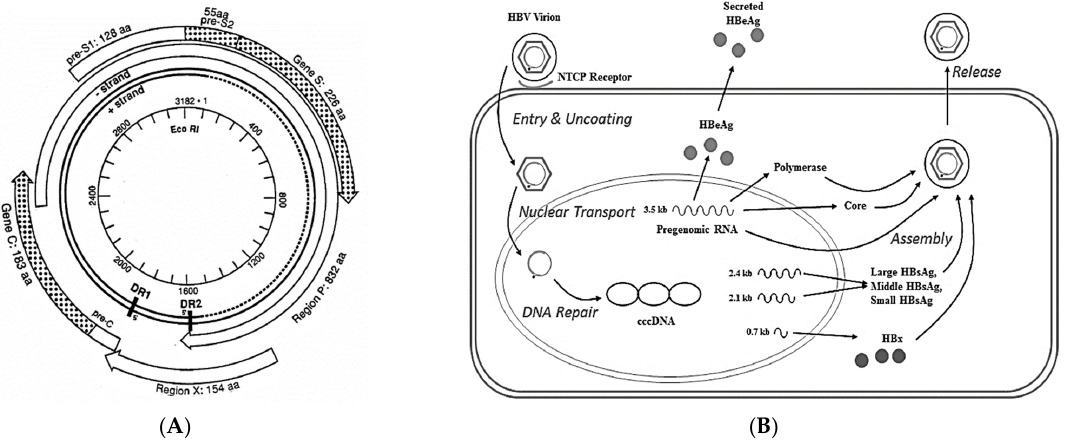
Figure 1. ( A ) Structure of the HBV genome as it exists in the virus particle. The open reading frames encoding the HBsAg polypeptides (gene S and preS), nucleocapsid (gene C), polymerase (region P) and HBx (region X) are shown. The genome has two direct repeat (DR) sequences: DR1 is adjacent to the nick in the long strand of DNA at the end of region X, which is the site on the HBV genome which integrates into host DNA. The short strand is of different lengths in individual virus particles. When the endogenous DNA polymerase inside virus particles fully lengthens this strand (so that the dotted line becomes solid), the DR2 is adjacent to the nick in the short strand [16]. ( B ) When